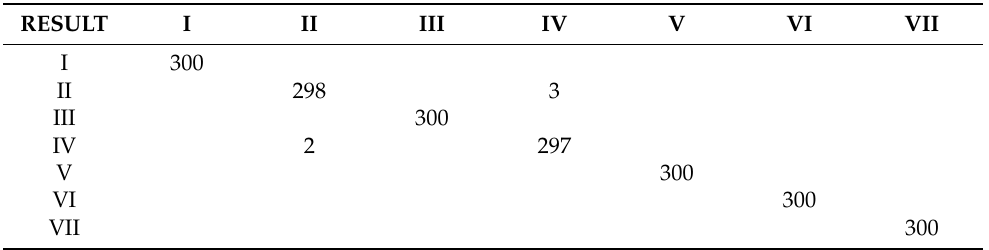
Table 2. Test results based on AlexNet model after training. I: no defect; II: edge defect; III: foreign- body defect; IV: fragmentation defect; V: void chip defect; VI: incorrect position defect; VII: repeatedly pasting defect.